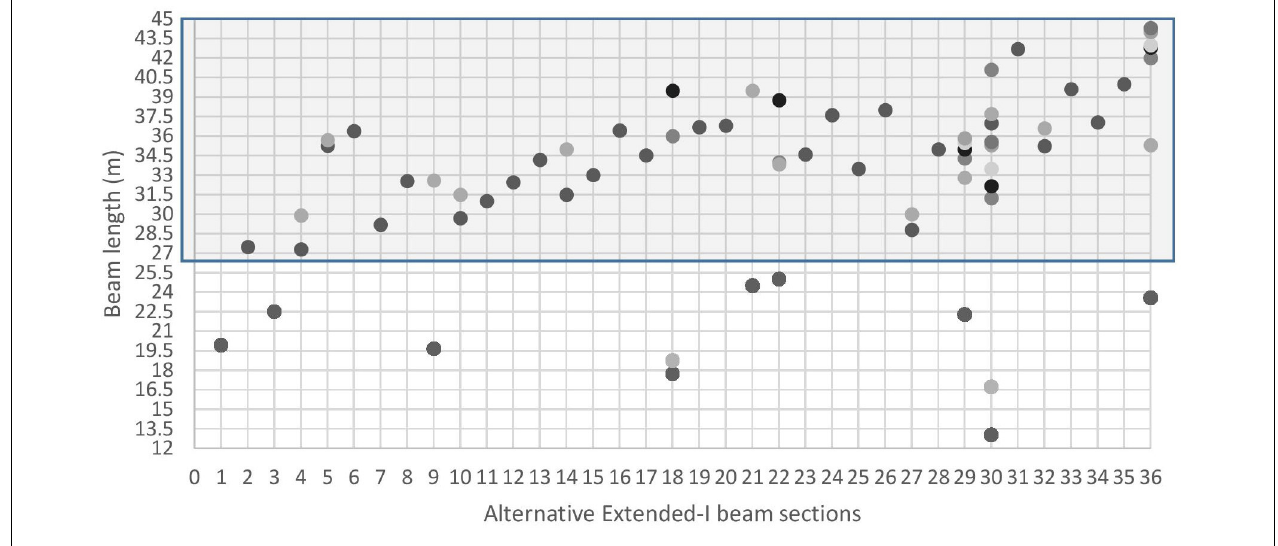
FIGURE 2 | Beam lengths per section.